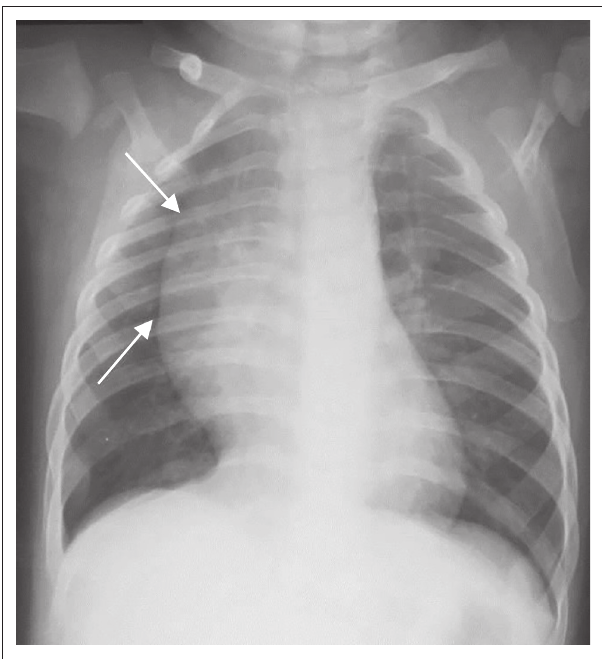
FIGURE 4: Frontal chest radiograph. Smooth undulations of the right lateral margins of the thymus from the overlying ribs and cartilages, the so-called ‘wave’ or ‘ripple’ sign (arrows).